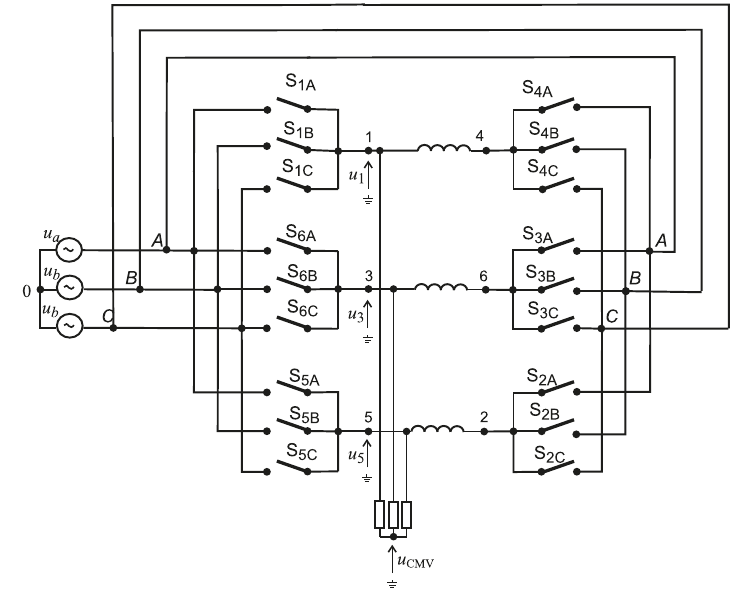
Figure 13. Scheme of three ‐ to ‐ six ‐ phase MC tested in experiment.